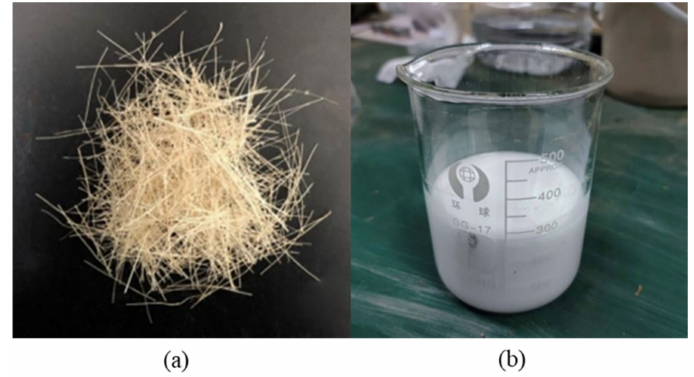
Figure 2. Reinforced materials: ( a ) 2 cm sisal fiber; ( b ) polyvinyl